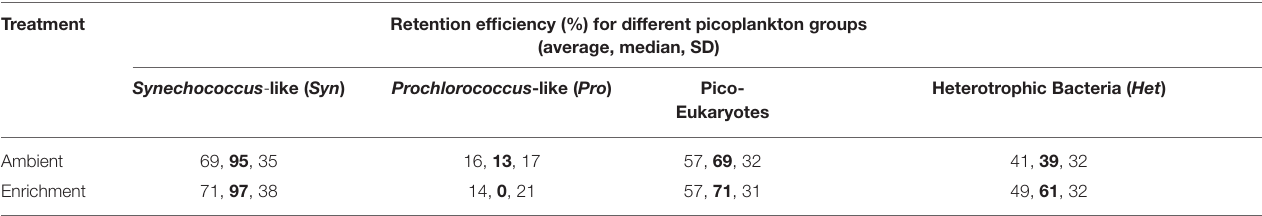
Bold values indicate